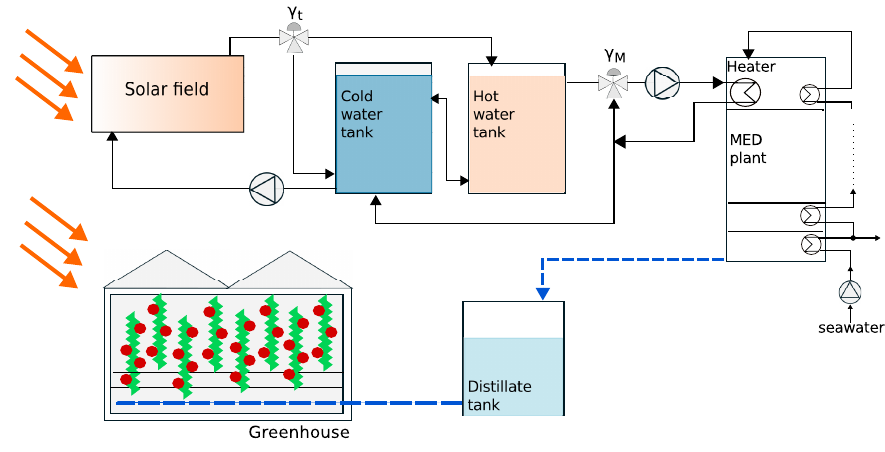
Figure 1. Solar desalination plant coupled with a